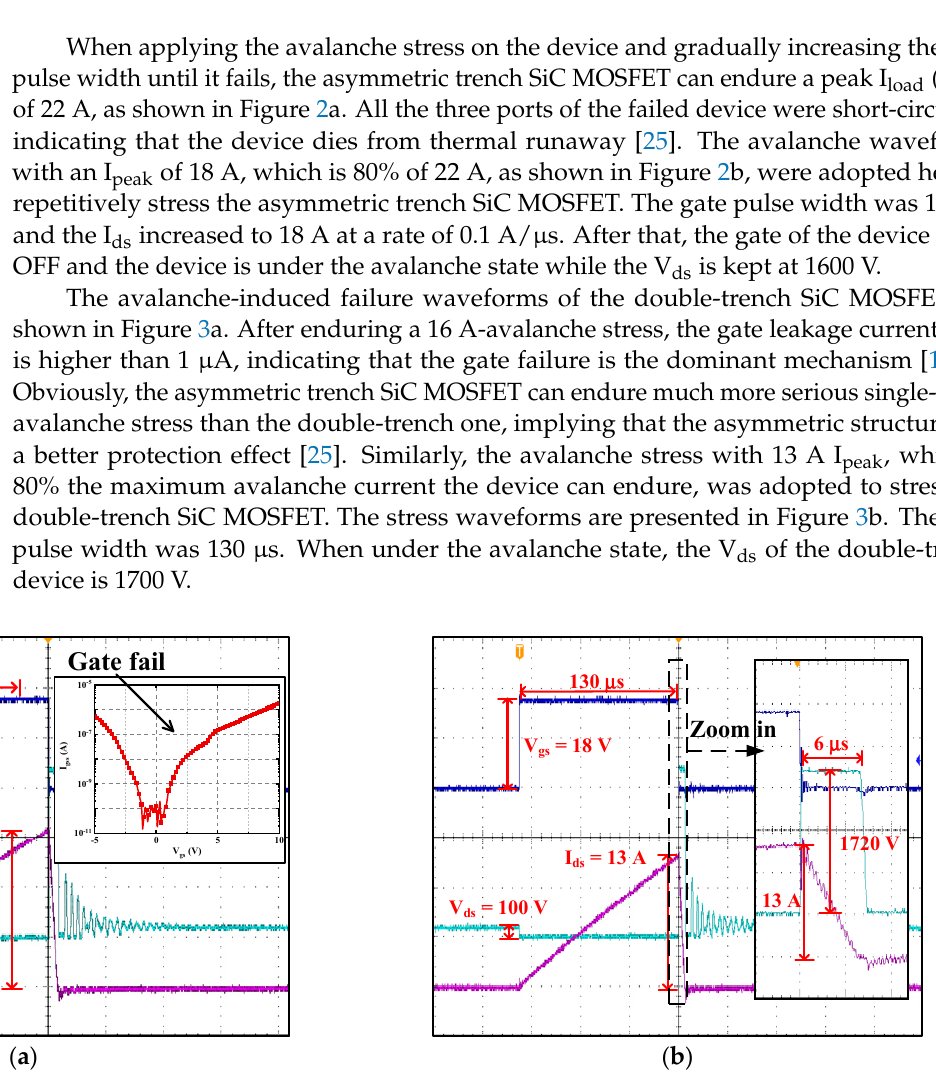
Figure 2. The avalanche waveforms of the asymmetric trench SiC MOSFET. ( a ) The failure wave- forms and the schematic circuit diagram of the avalanche stress system. ( b ) The waveforms adopted to stress the device.